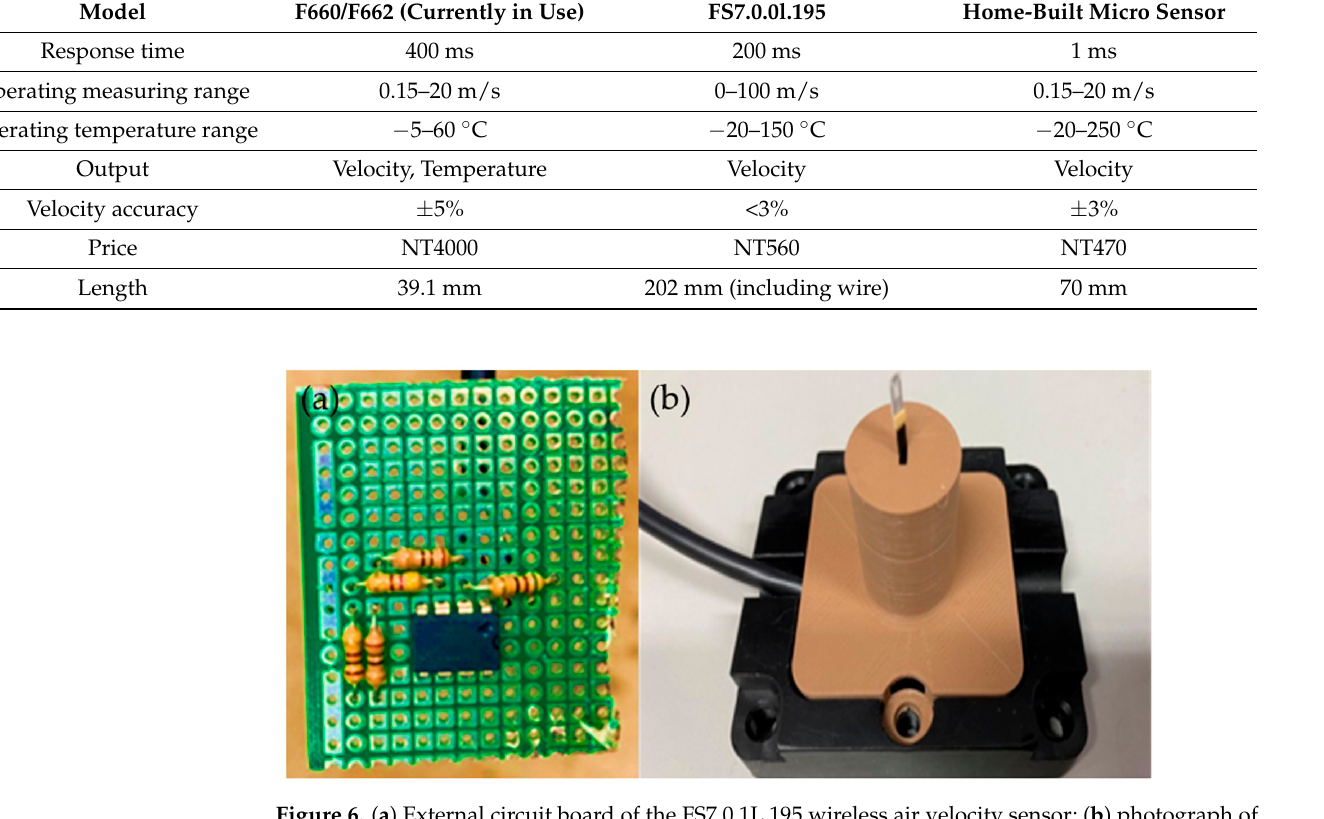
Figure 6. ( a ) External circuit board of the FS7.0.1L.195 wireless air velocity sensor; ( b ) photograph of self-developed packaging conforming to FS7.0.1L.195 dimensions.